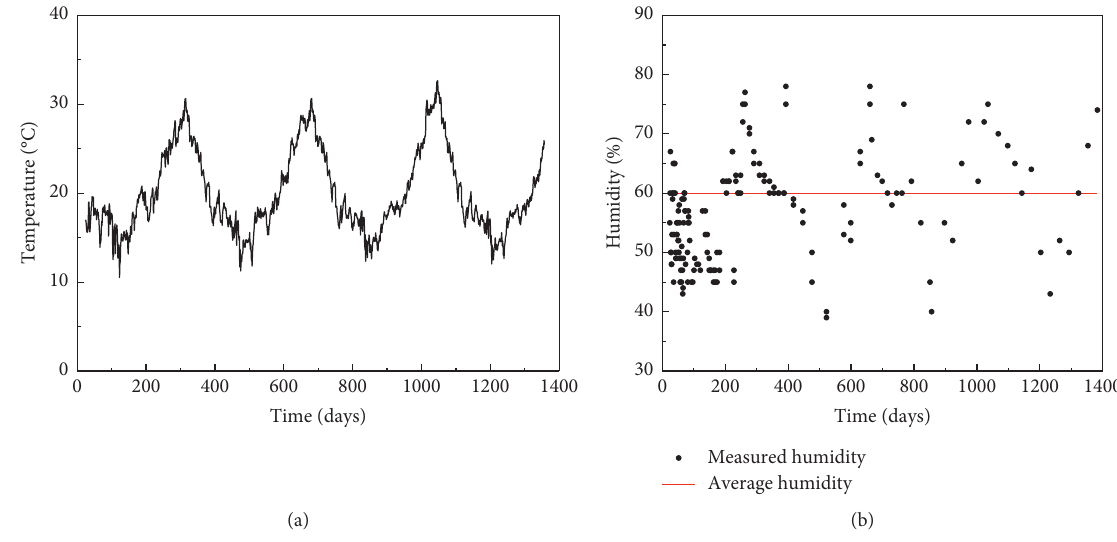
Figure 4: Ambient temperature and relative humidity during the monitoring period: (a) temperature; (b) relative humidity.